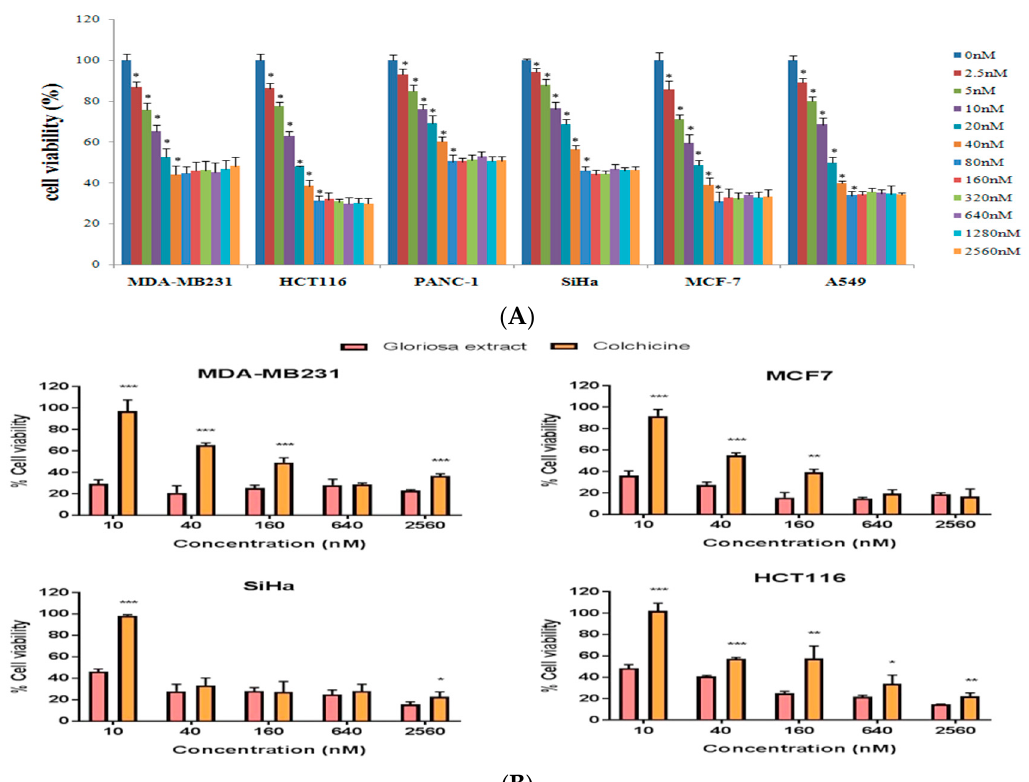
Figure 4. ( A ) E ff ect of colchicine on cell viability in six human cancer cell lines (MDA-MB231, HCT116, PANC-1, SiHa, MCF-7, and A549) based on Crystal Violet Assay. ( B ) The comparative e ff ect of colchicine and Gloriosa extract (Colchicine content in Gloriosa extract) on cell viability against four human cancer cell lines (MDA-MB231, HCT116, SiHa, and